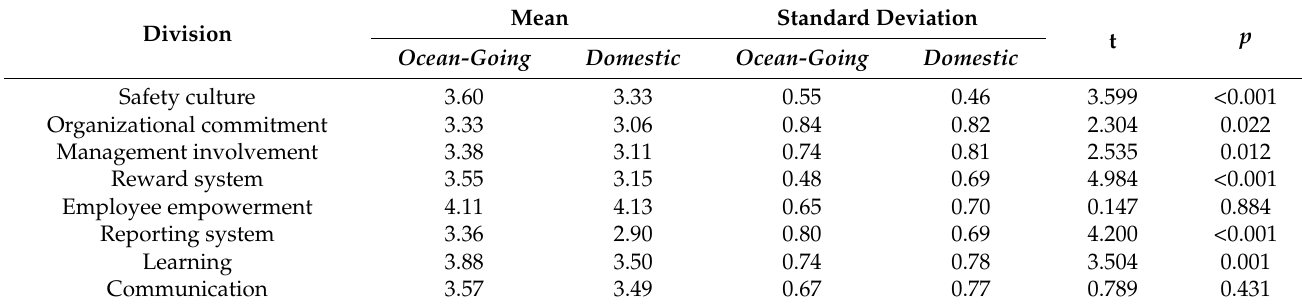
Table 7. Results of t-test (Source: adapted from: [8]).